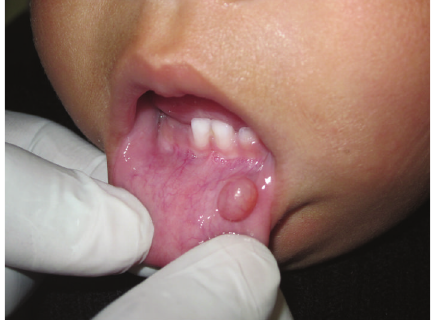
Figure 3: Immediate postoperative view.